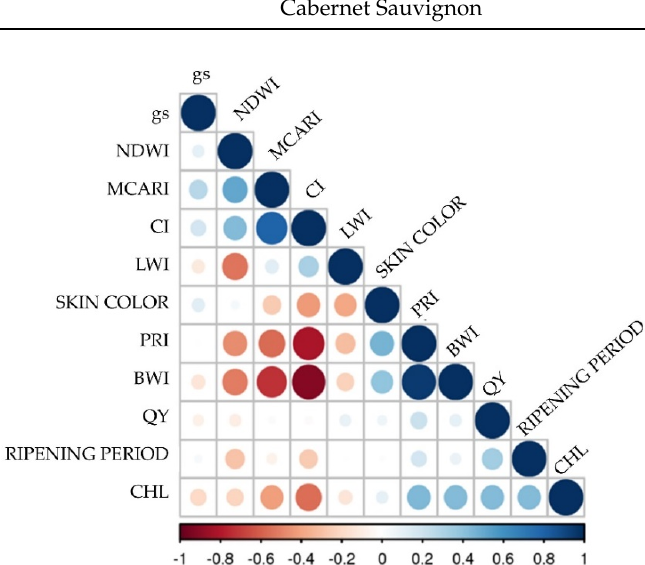
Figure 2. Correlogram (Pearson’s coefficient) of the hyperspectral indices, physiological and berry trait parameters for the 15 selected varieties. Positive correlations are displayed in blue and negative correlations in red. Circle diameter and color intensity are proportional to the correlation values as reported in the